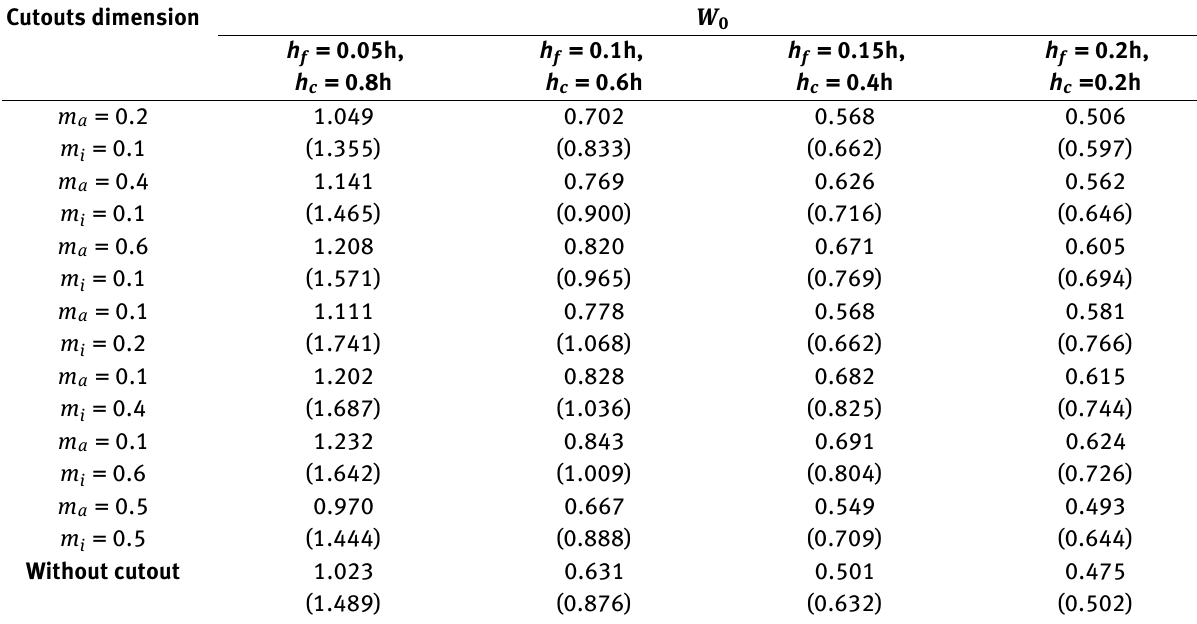
Table 4: Effect of cutout dimensions with thickness of face and core on NTMD of simply supported (S2) laminated sandwich square plate (45/ − 45/C/45/ − 45) Cutouts